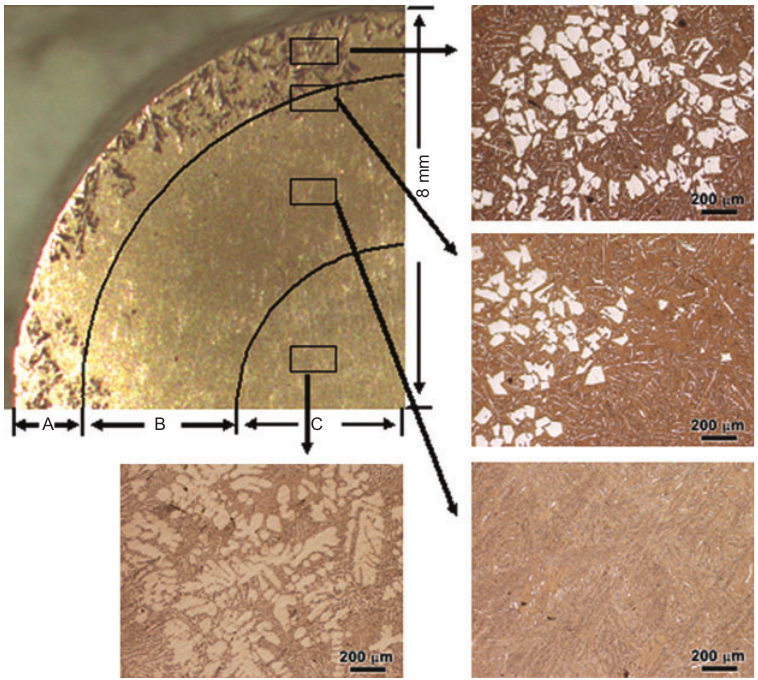
Figure 3 A quarter of the transverse macrostructure of the sample of the Al-22.9 wt. % Si solidifi ed from 1023 K at a cooling rate of 30 K/min under a TMF intensity of 45 mT and the corresponding